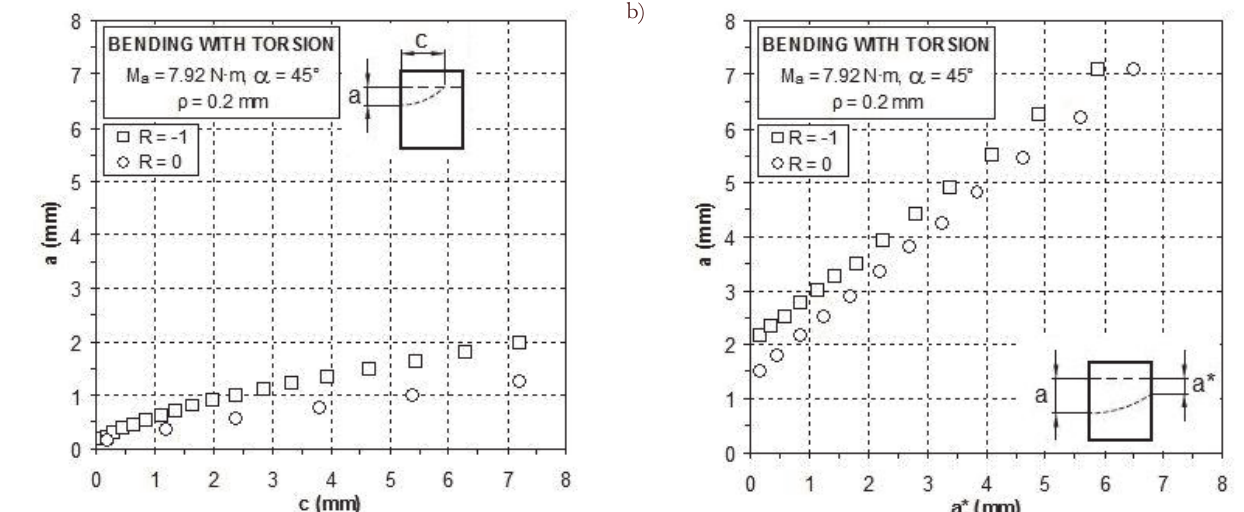
Figure 5: Fatigue crack length under bending with torsion for: a) cracks edge quarter-elliptic, b) through cracks on both specimen sides: active and passive.